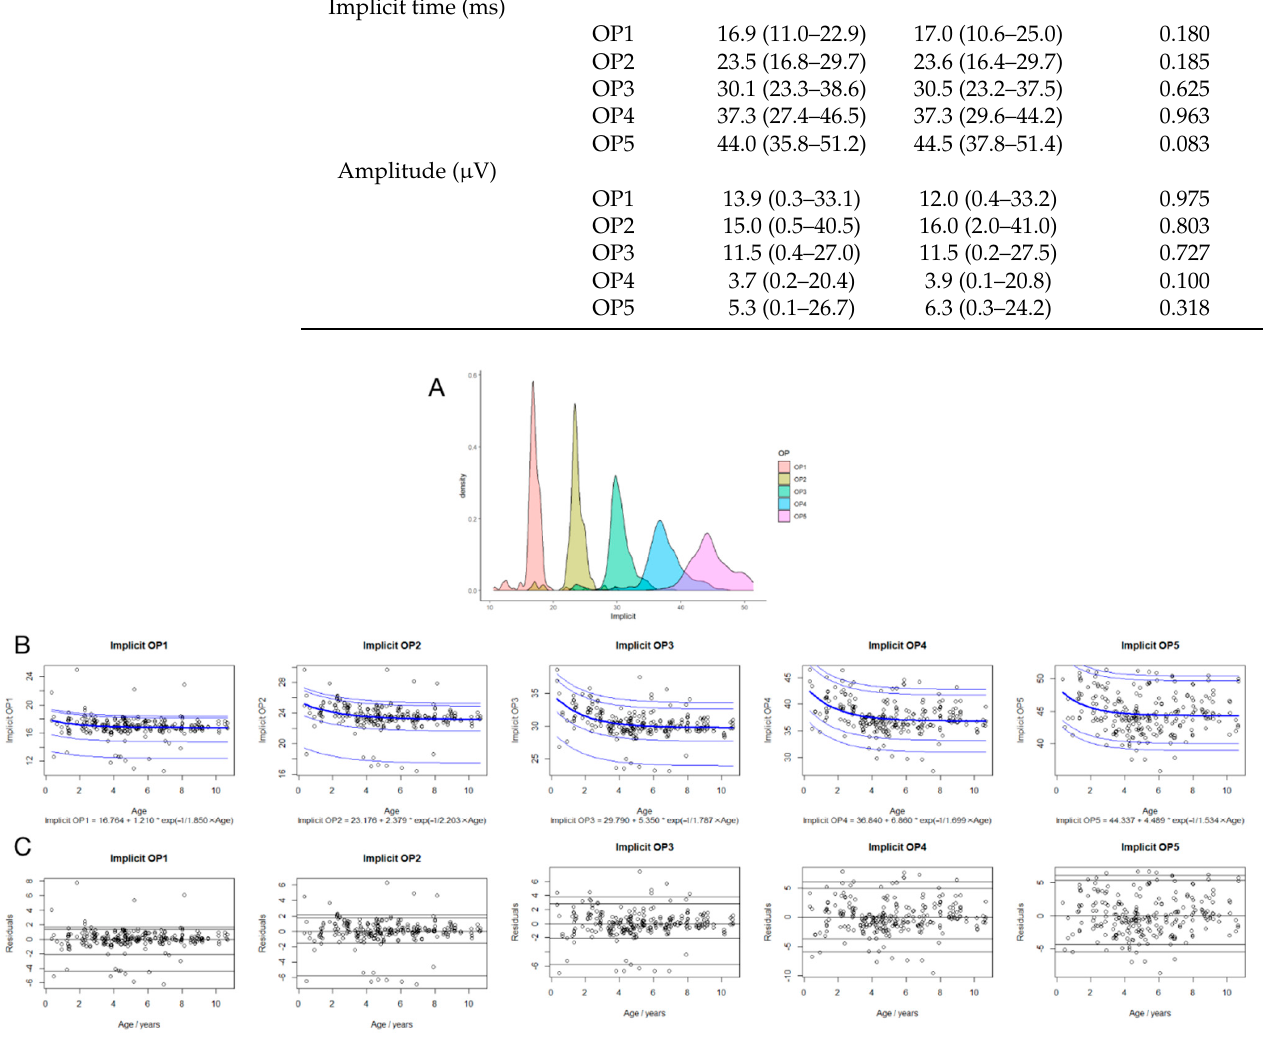
Figure 2. The implicit times of OPs dependence on age. The density plot for the implicit times of OP1-5 ( A ). OPs implicit times ( B ) are shown versus age. The fit equation for the bold curve (labeled 50th percentile) is shown at the bottom of the plot. Other percentiles with additive offsets are shown with thin blue lines. Fit residuals of regression ERG dependence on age ( C ). Fit residuals or differences between measurements and fitted equations are shown as implicit times. Each patient has one symbol per